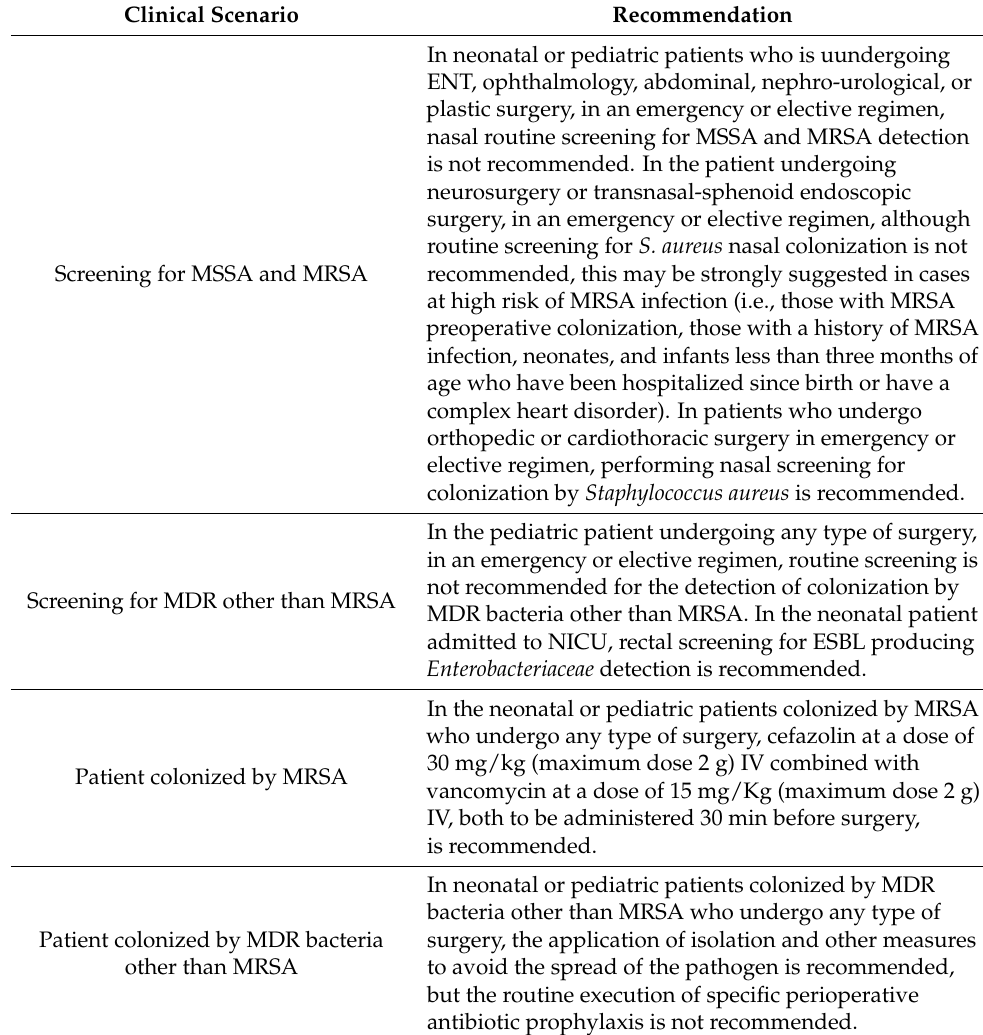
Table 1. Surgical antimicrobial prophylaxis (SAP) for neonates and children with special high- risk